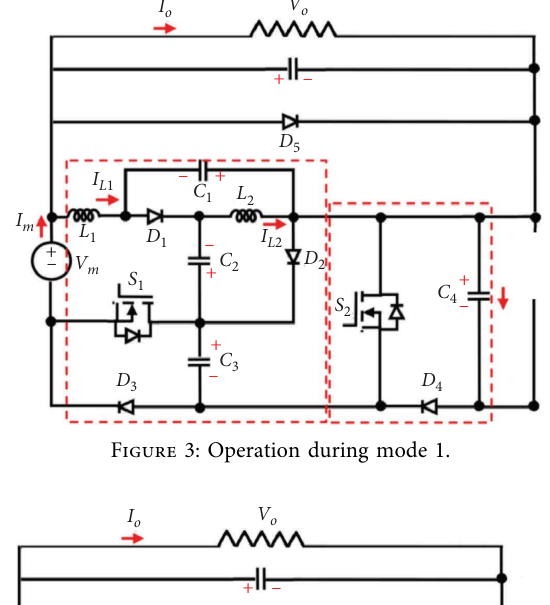
Figure 3: Operation during mode 1.